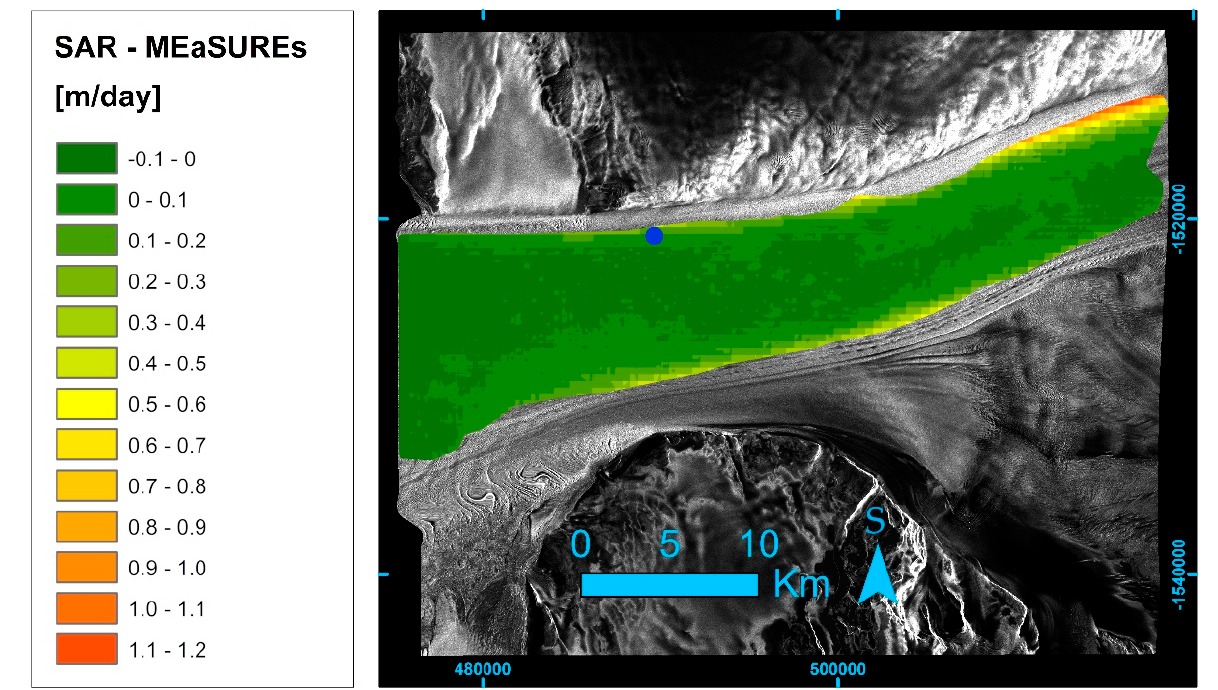
Figure 8. Differences between the horizontal daily velocities of SAR pair 1 and the ones of the MEaSUREs InSAR-Based Antarctica Ice Velocity Map, Version 2. The blue dot corresponds to the position of DRY1 GPS point. Coordinates are expressed in Antarctic Polar Stereographic mapping projection.